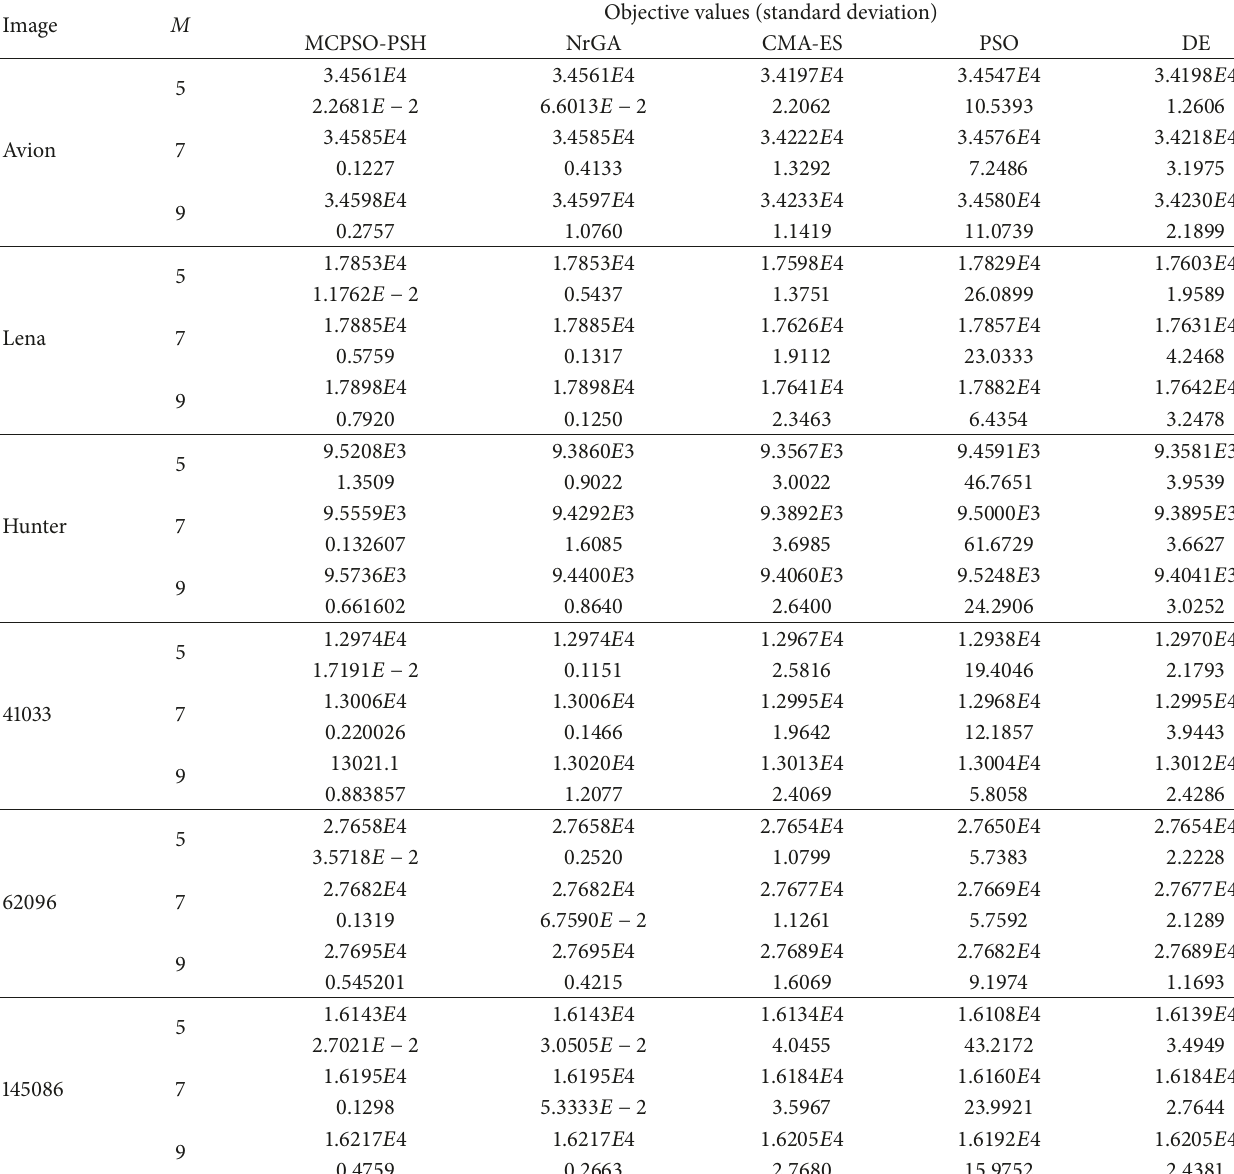
Table 7: Objective value and standard deviation by the compared EA-based methods on Otsu